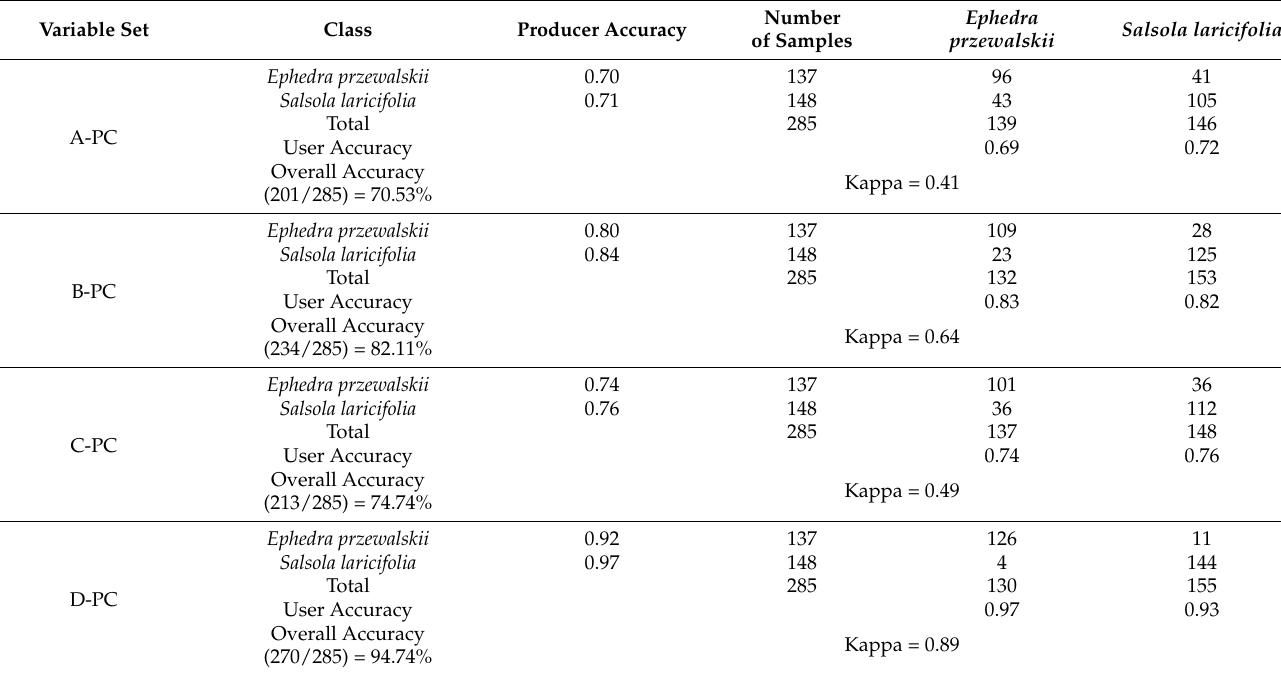
Table A6. Comparison of classification accuracies of individual shrub species maps from the EPPR–SALA alliance of four sets of variables generated by the random forest (RF) model.